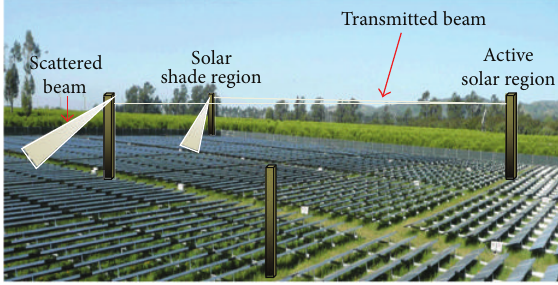
Figure 12: Solar farm with concentrator pillars at SSS boundaries.